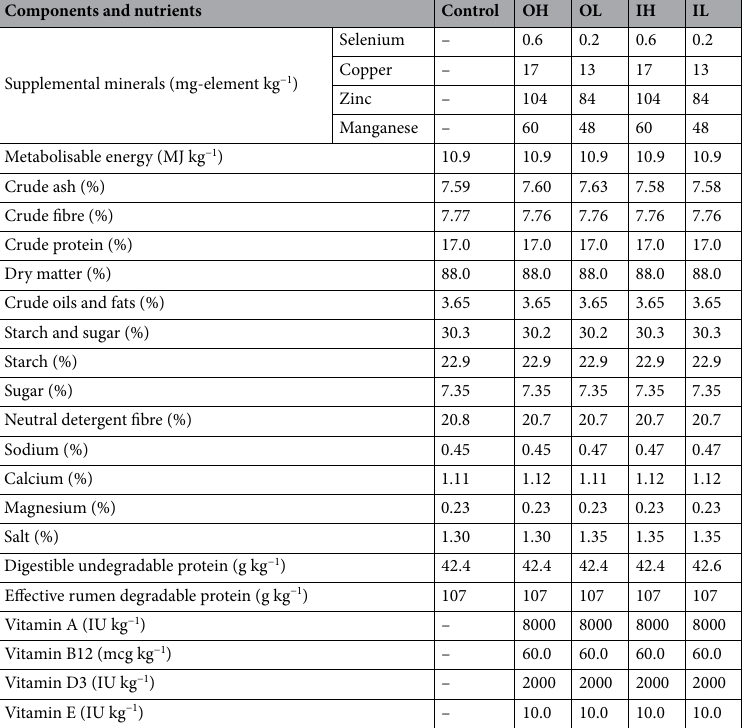
Table 1. Nutrient and energy content of the concentrate feed. OH organic minerals offered at higher doses, OL organic minerals offered at lower doses, IH inorganic minerals offered at higher doses, IL inorganic minerals offered at lower